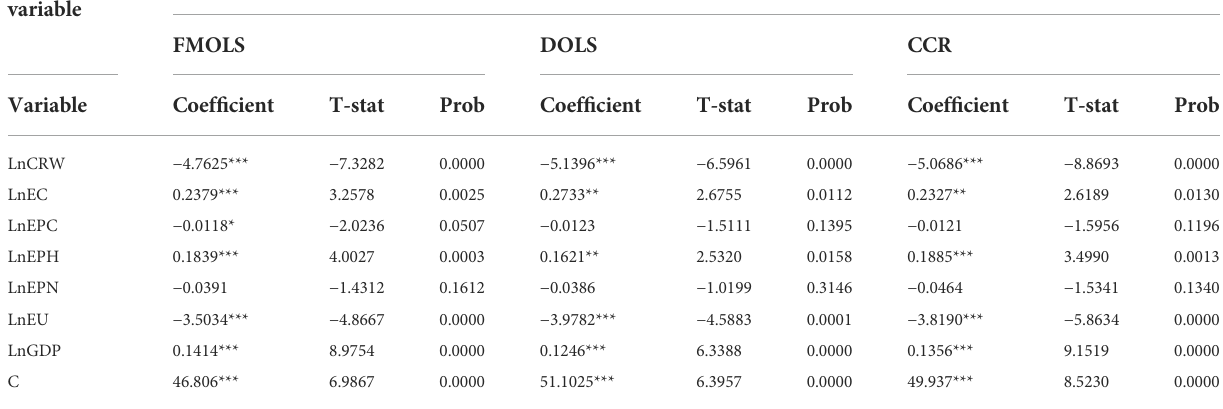
TABLE 10 FMOLS, DOLS and CCR Long-run coef fi cient